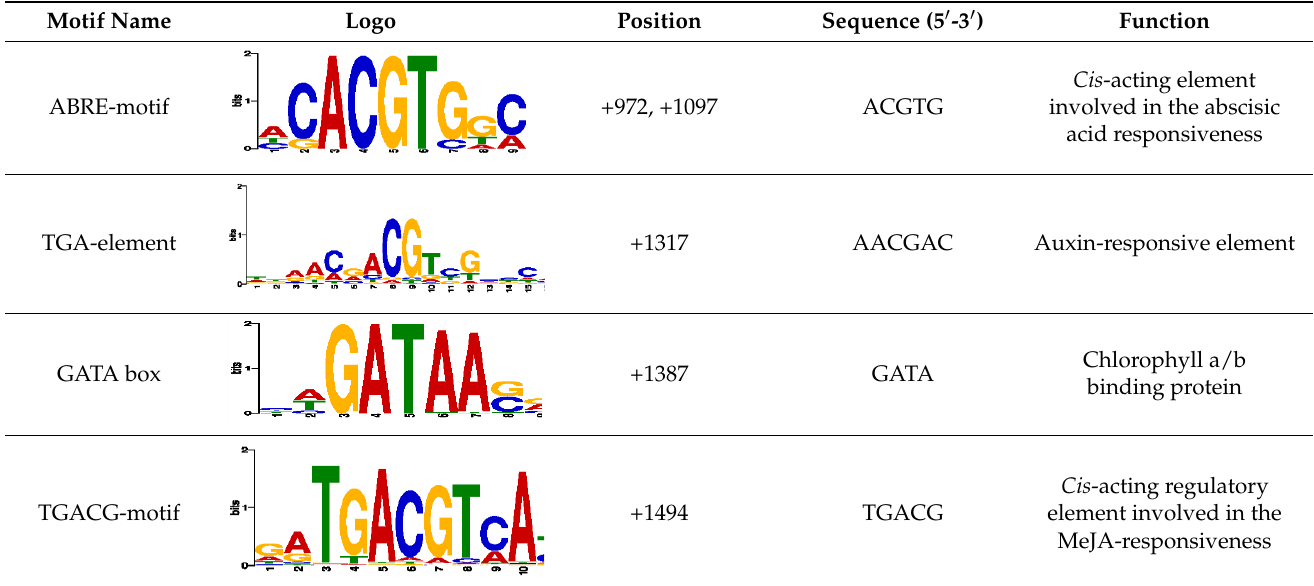
Table 2. Atore1/nac2 binding to four cis -regulatory elements (CREs) core motifs identified by PlantCARE.